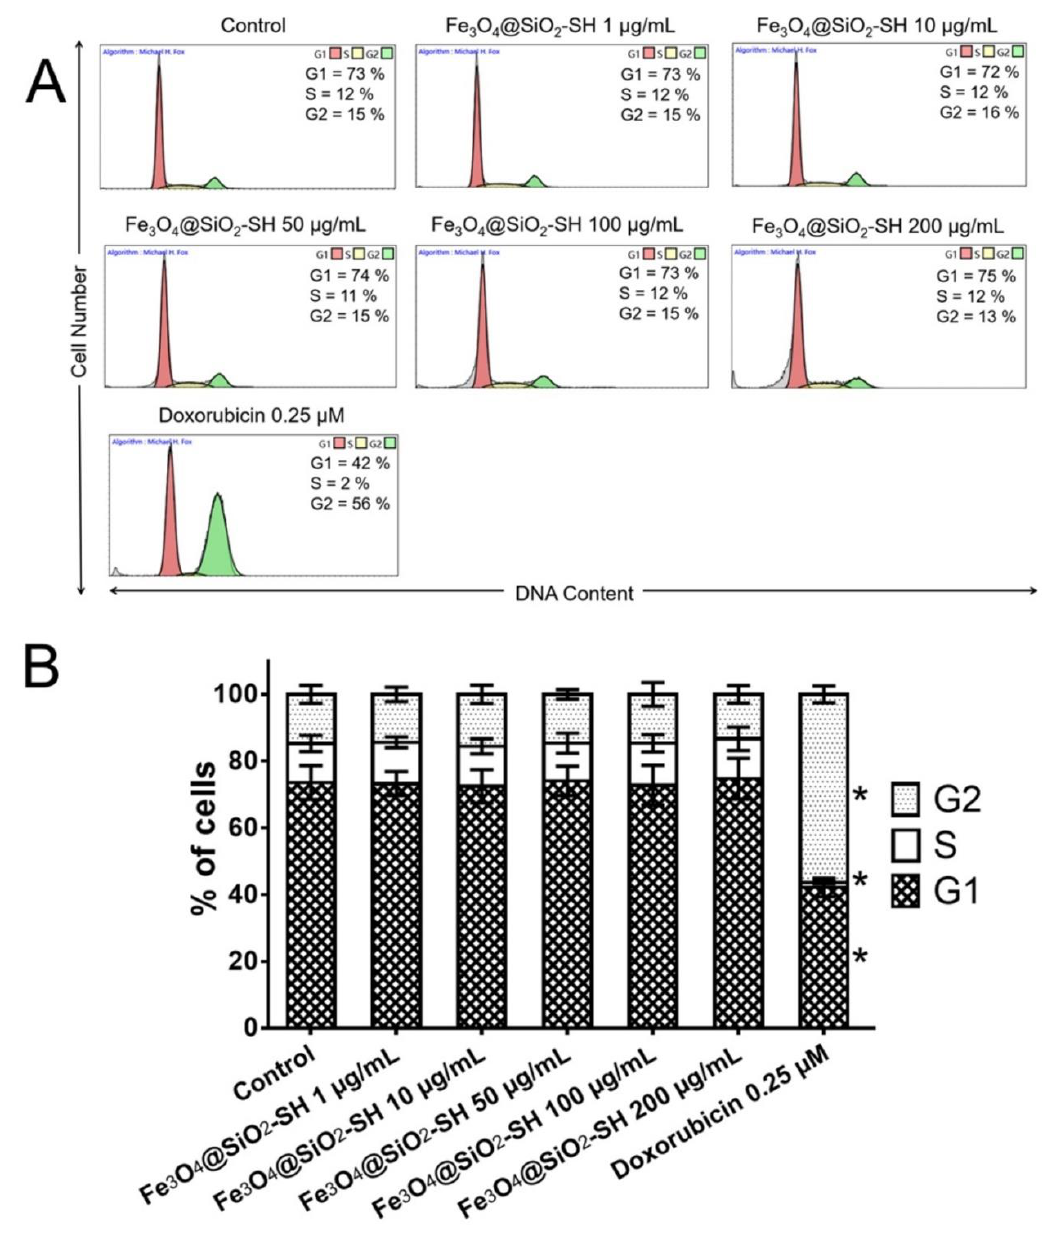
Figure 7. Analysis of the cell cycle after the treatment with Fe 3 O 4 @SiO 2 -SH nanoparticles at 1, 10, 50, 100, and 200 µg/mL. ( A ) The figure shows representative histograms of human A549 lung carcinoma cells after the 48 h interval with the mean percentage of cells cycling through phases G1, S, and G2 based on flow cytometry measurement of three separate treatments. ( B ) The bar graph summarizes cumulative data on the percentage of cells in each phase of the cell cycle. Cells treated with 0.25 and 0.5 µM doxorubicin were used as a positive control. Data are presented as the mean values ± SD from three experiments. * — significantly different from the control ( p ≤ 0.05).